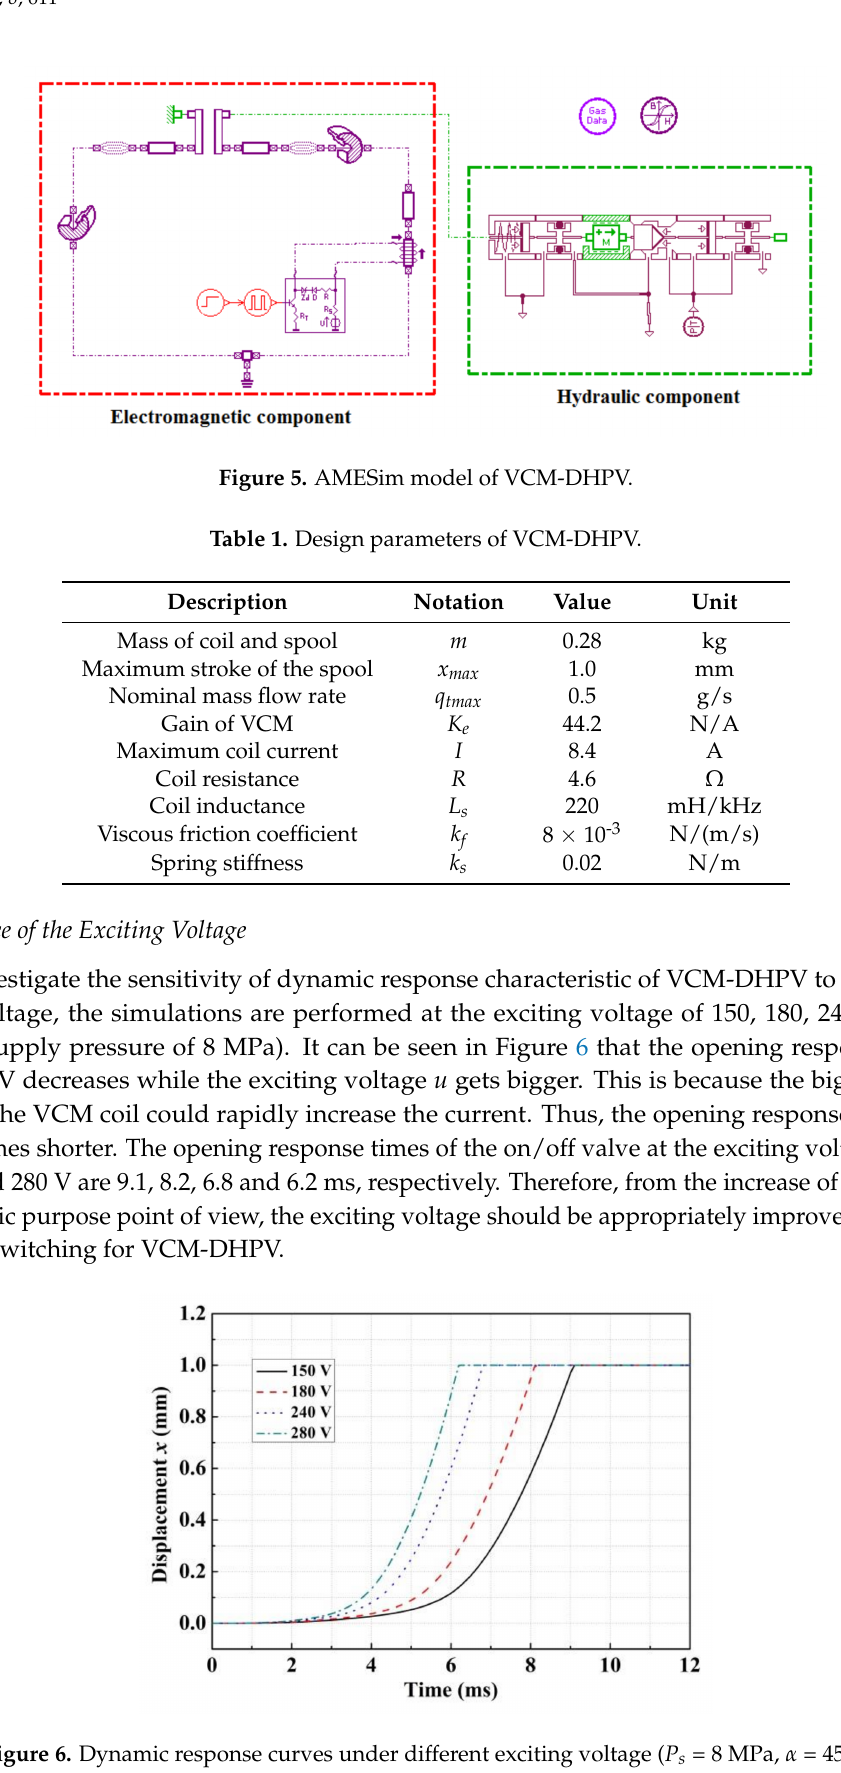
Figure 6. Dynamic response curves under different exciting voltage ( P s = 8 MPa, α = 45 ◦